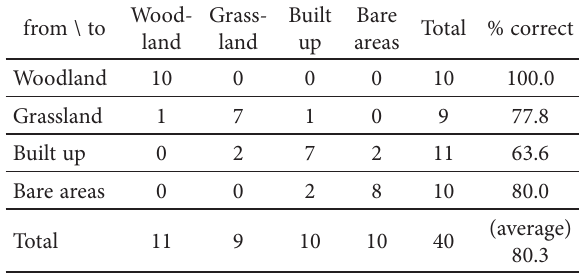
Table 5. Confusion matrix for the estimation sample.